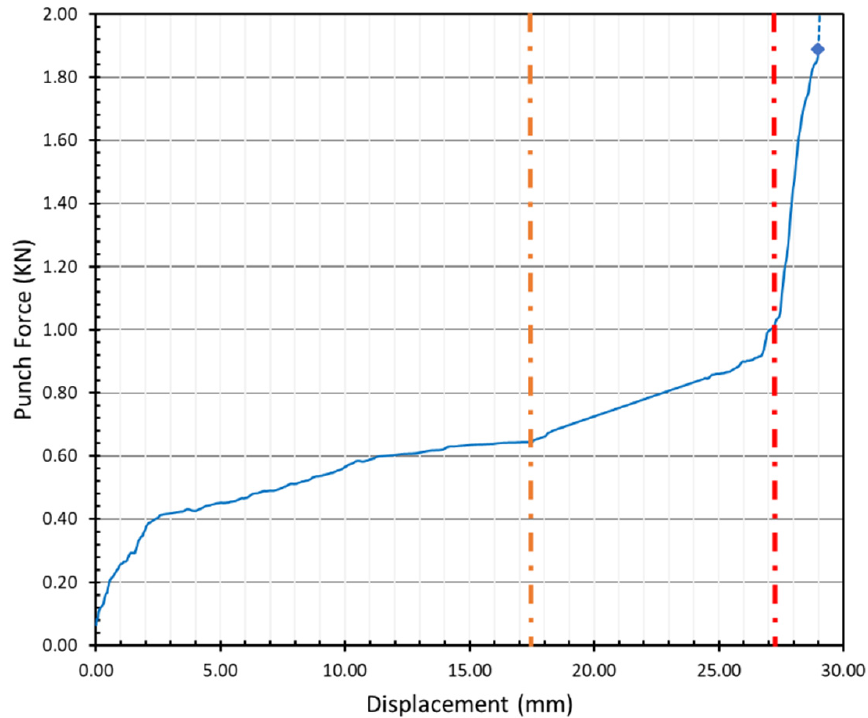
Figure 16. Force–displacement diagram of base plasticine clinch joint (12–8 mm) with glycerin and process time of 1 s.